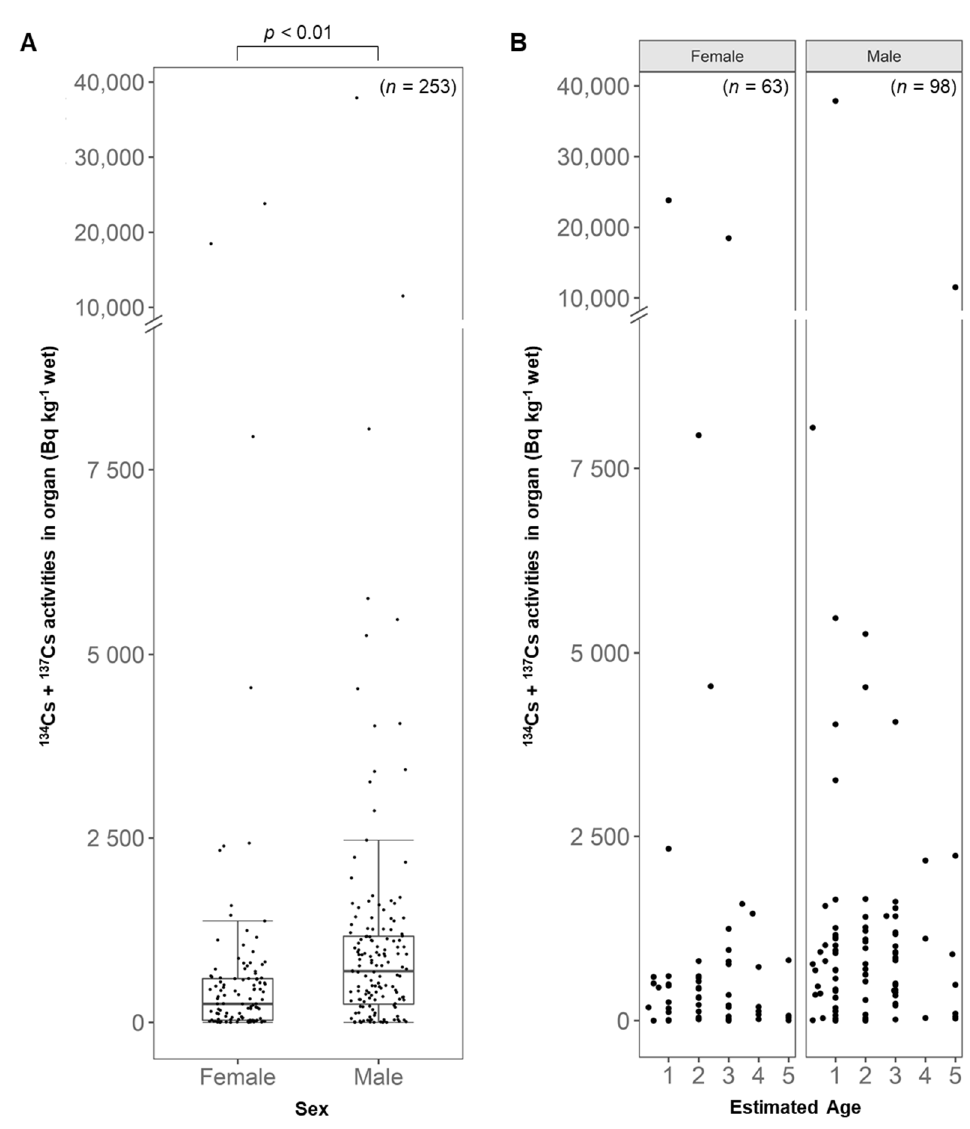
Figure 5. ( A ) An overall comparison and ( B ) a comparison with available estimated age of 134 Cs + 137 Cs activity concentrations in reproductive organs between male and female cats. Boxplot represents its distribution and black dots shows individual 134 Cs + 137 Cs activity concentrations in reproductive organs.